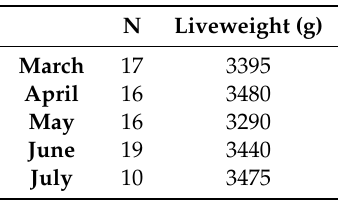
Table 1. Distribution of number of does (n) and liveweight per